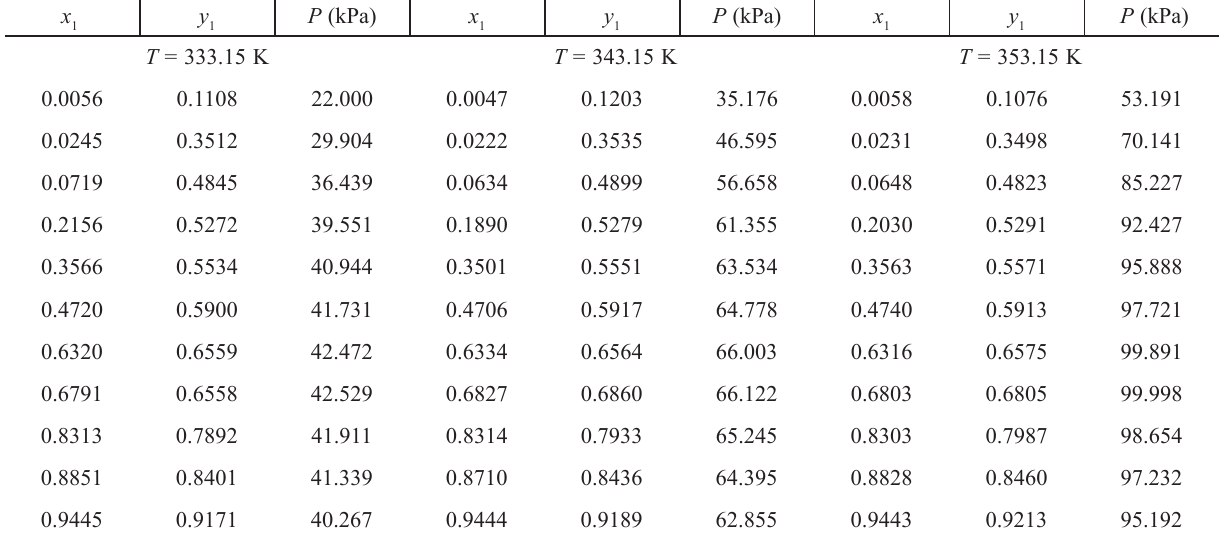
Table 1 – Vapor-liquid equilibrium in the 2-propanol + water (2) system x 1